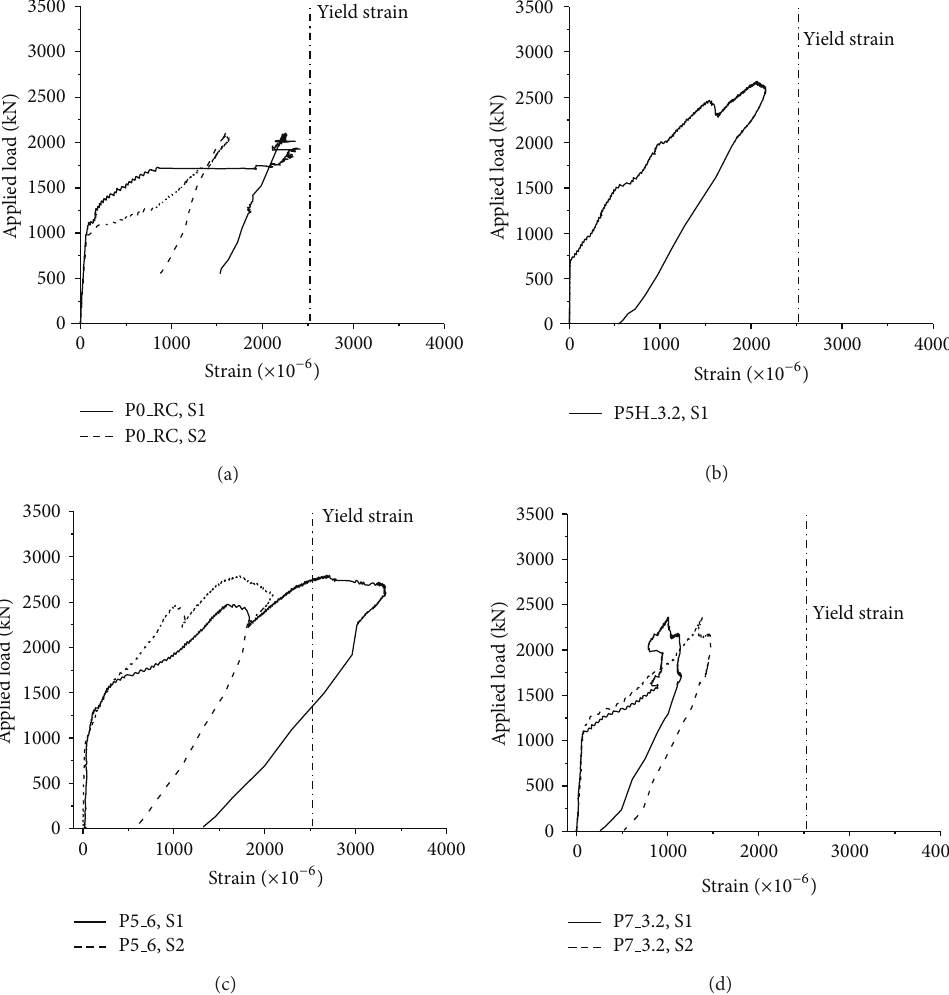
Figure 6: Applied load versus strain in the reinforcing bar: (a) P0 RC; (b) P5H 3.2; (c) P5 6; and (d) P7 3.2.